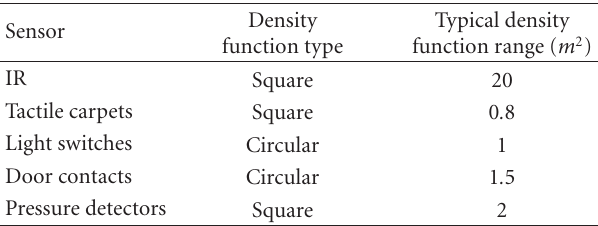
Table 2: Density functions per sensor